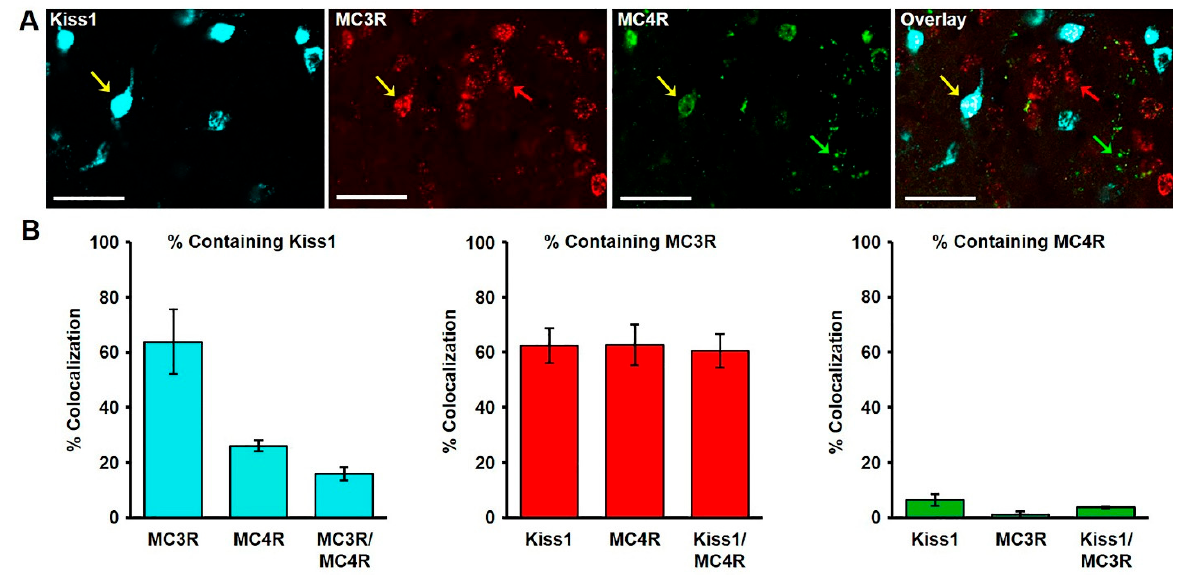
Figure 2. ( A ) Confocal image (1.0 µ m optical section; 20 × magnification) of kisspeptin, MC3R, and MC4R mRNA-expressing cells in the arcuate nucleus (ARC) of a castrated male sheep. Yellow arrows indicate a Kiss1 cell expressing both MC3R and MC4R. Red and green arrows show MC3R and MC4R-expressing cells, respectively. Scale bar, 50 µm. ( B ) Mean (± SEM) percentage of kisspeptin (left), MC3R (middle), and MC4R (right) cells containing Kiss1, MC3R, and/or MC4R in the middle ARC.